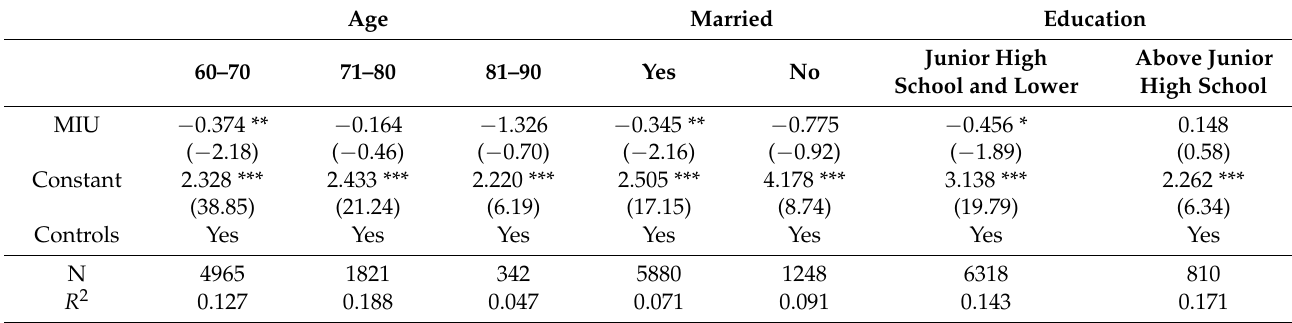
Table 4. Heterogeneity analysis